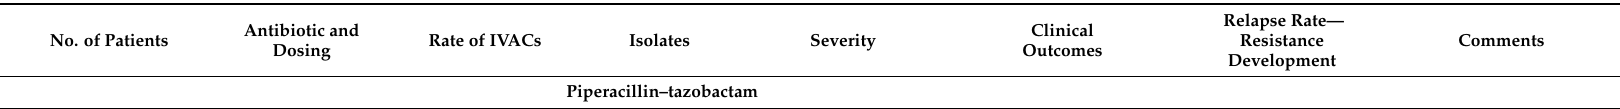
Table 1. Summary of the studies investigating the treatment of multi-susceptible Pseudomonas aeruginosa infection-related ventilator-associated complications (IVACs) with piperacillin–tazobactam or fourth-generation